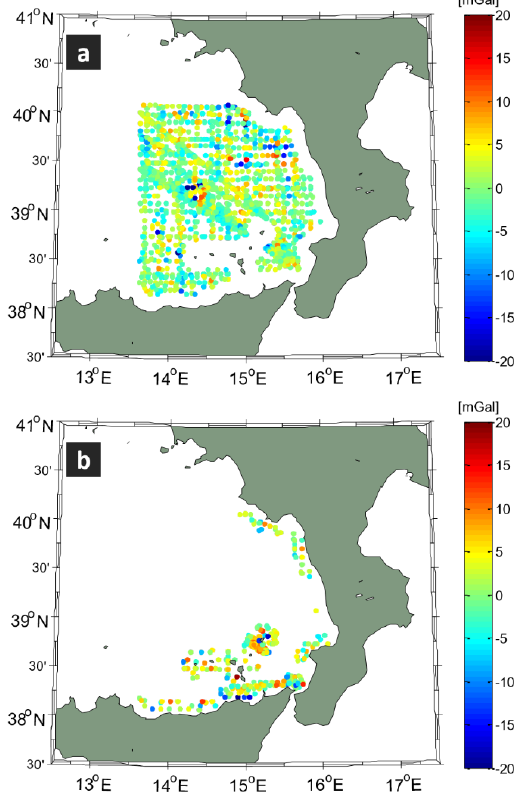
Fig. 6. Difference of (LARS) altimetric gravity anomalies and ship- borne gravity (a) over the open ocean (std.=4.56 mGal), (b) in the coastal area (std.=5.91 mGal). Most of the "coastal area" samples are located around the Aeolian islands and north of Sicily island.